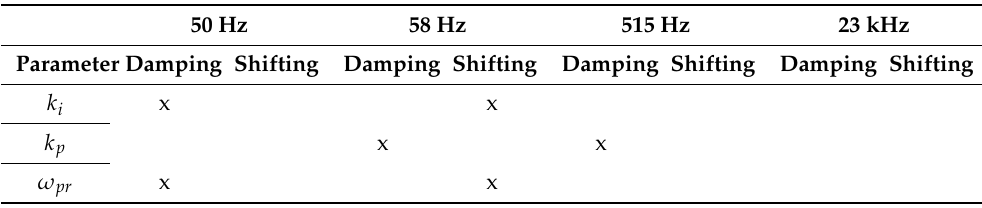
Table 3. Summary of the effect of the controller and filter parameters on the resonant frequency points of the output